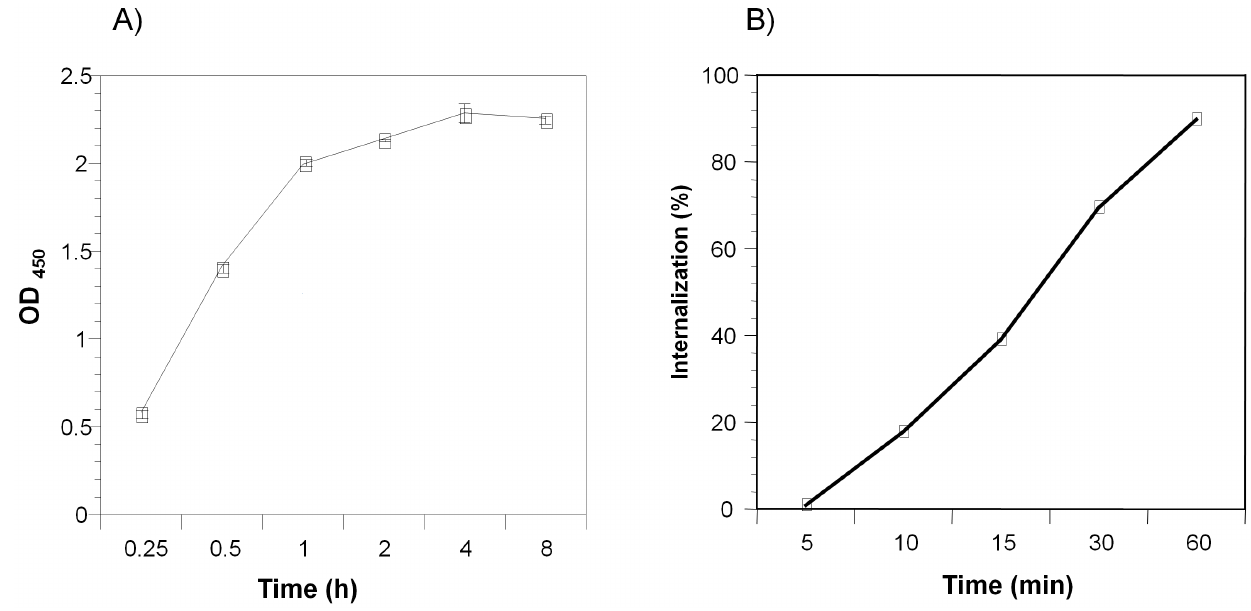
Figure 4. Binding and internalization of biotin-labeled rCARDS toxin. (A) Biotin-labeled rCARDS toxin binding to HeLa cells is time- dependent. HeLa cells were treated with 10 m g/ml of biotin-labeled rCARDS toxin for 15 min to 8 h at 4 u C. After removing unbound toxin by washing, we analyzed binding using horseradish peroxidase-conjugated streptavidin. Cell-bound rCARDS toxin was measured at 450 nm using ELISA reader as described in Materials and Methods. (B) Internalization of rCARDS toxin in HeLa cells. HeLa cells were treated with 10 m g/ml of biotin- labeled rCARDS toxin for 30 min at 4 u C and then incubated at 37 u C for the indicated times after removing unbound toxin by washing. At specific time intervals, cells were fixed and surface-bound biotin was removed with MESNA. Internalized biotin-associated rCARDS toxin was quantified as described in Materials and Methods. Data are means 6 SD of triplicate samples.